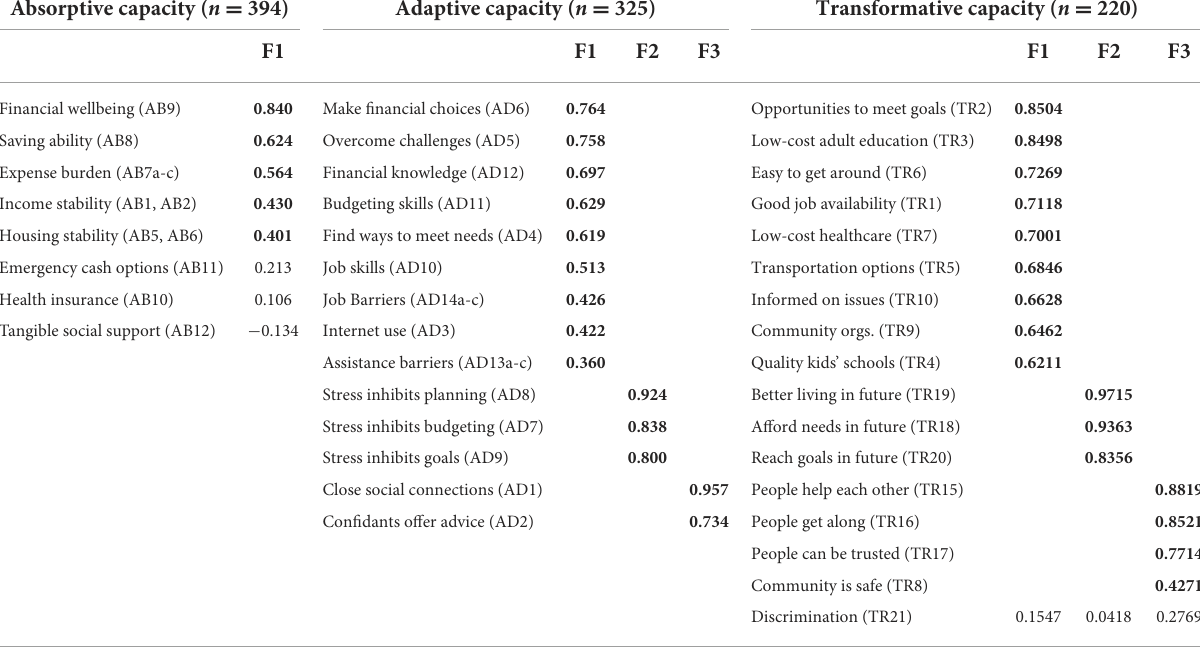
TABLE 2 Exploratory factor analysis showing the factor structures of the three new measures. Absorptive capacity ( n =